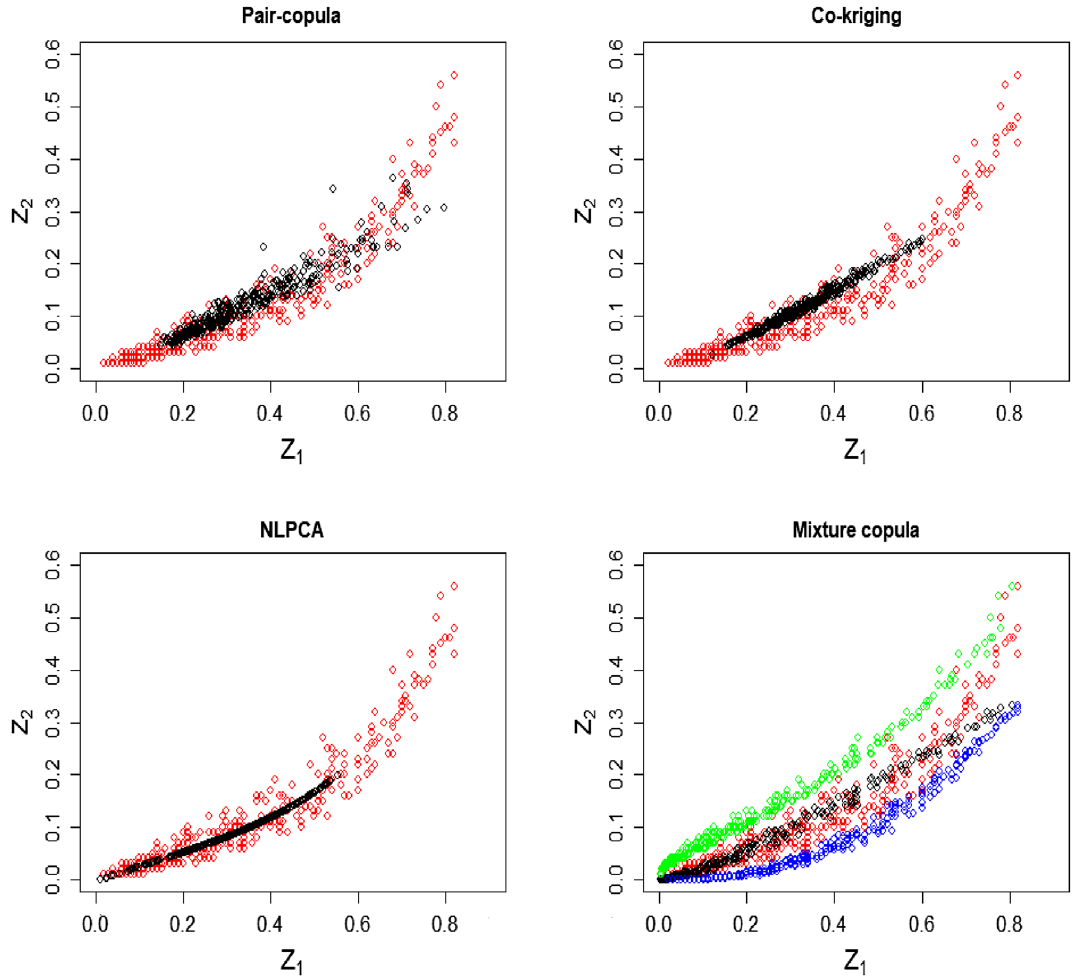
Figure 5. Reproduction of bivariate relationship using various methods. Actual (red), predicted (black), Z 1 given Z 2 (green), and Z 2 given Z 1 (blue).